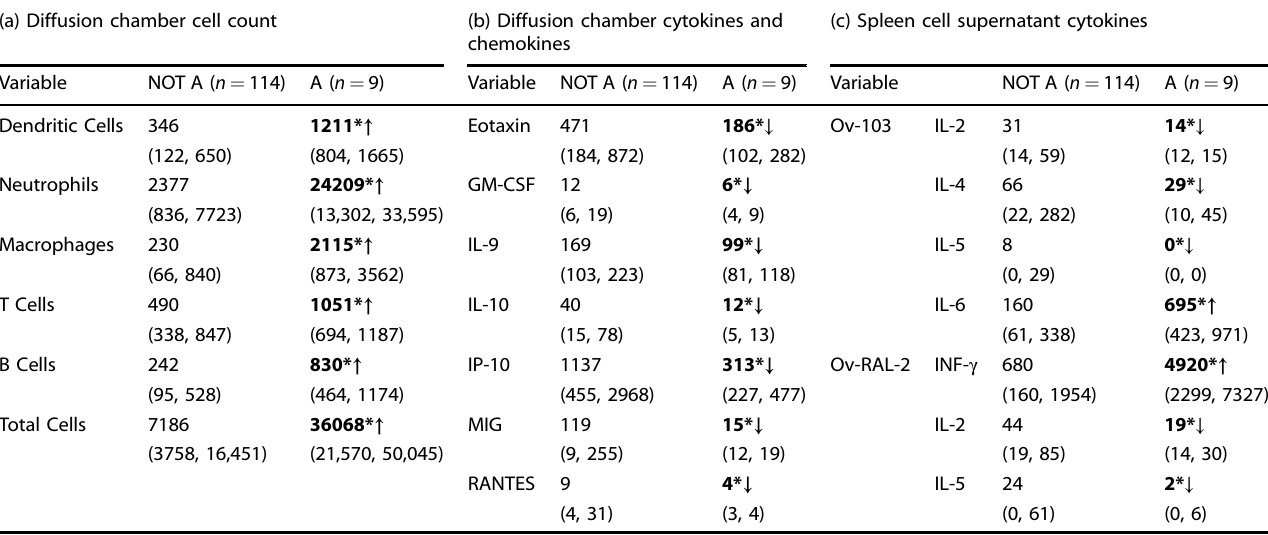
Table 3. Comparison between immune factors measured in Line A control mice compared to levels measured in CC-RIX and BALB/cByJ control mice. (a) Diffusion chamber cell